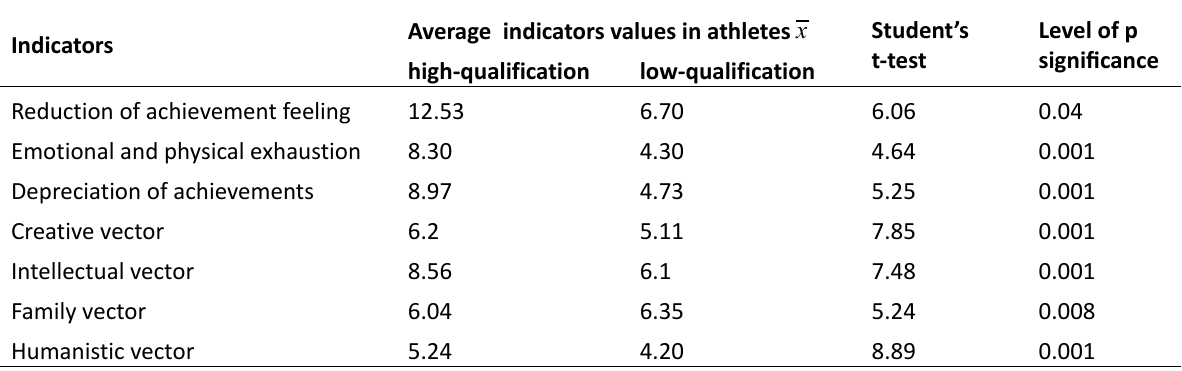
Table 1. Statistical indicators of high and low qualification athletes (n = 187)